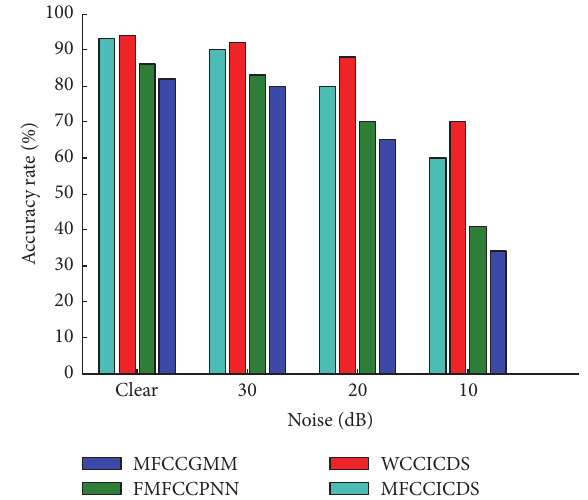
Figure 4: The accuracy rates of speaker recognition in noisy